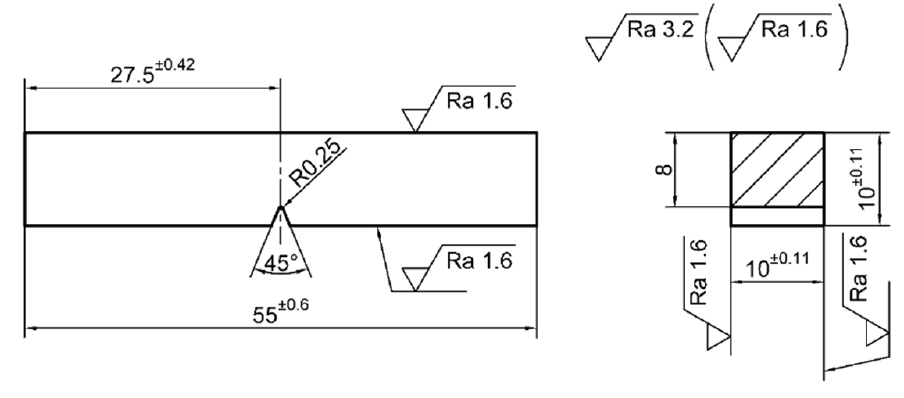
Figure 3. Impact toughness test samples, shape and dimensions.